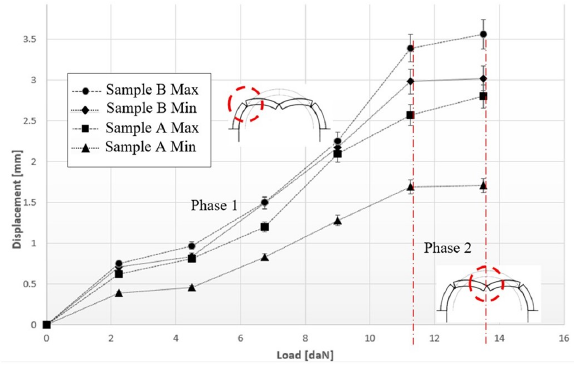
Figure 16: The trends related to the minimum and the maximum displacement measured in grids A and B are reported. In particular, two different phases are recognized, phase 1 and phase 2 (immi- nent collapse condition). La stationarity of the function dp 4 / dL denounced the imminent condition corresponding to the collapse of the